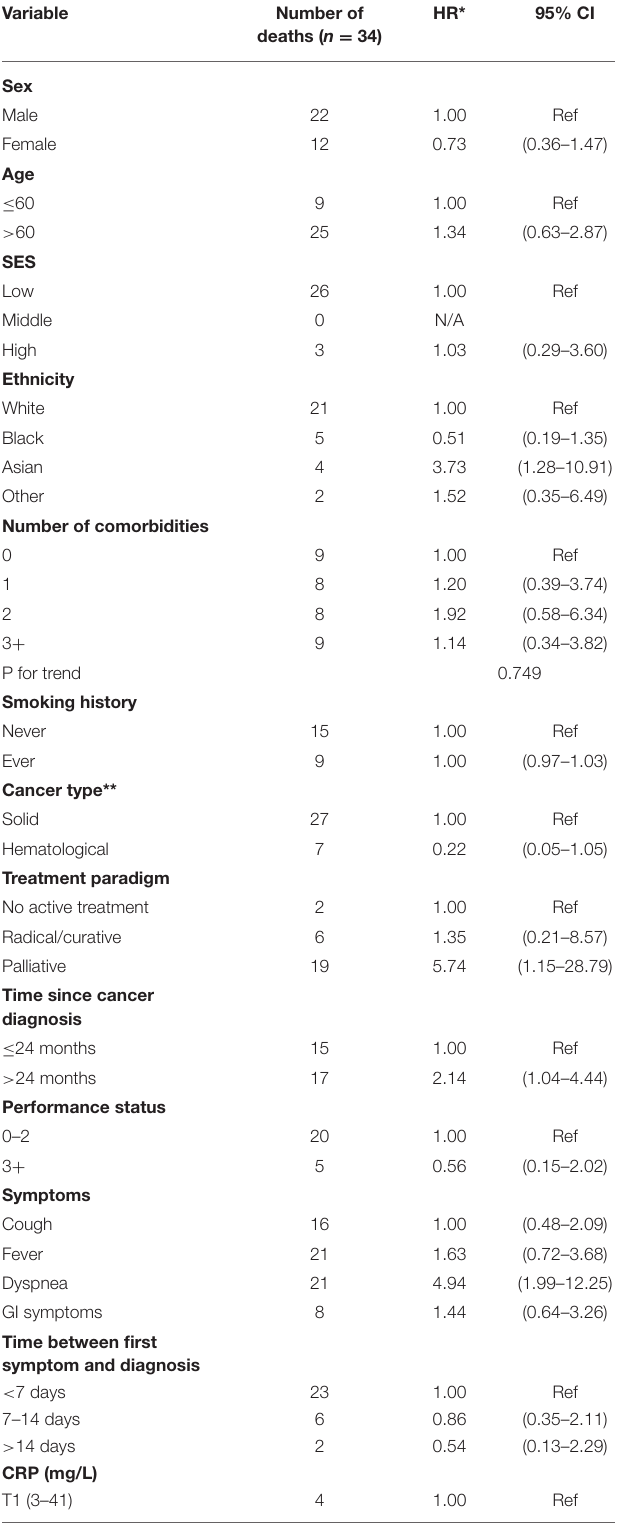
TABLE 5 | Hazard Ratios and 95 %Confidence intervals for COVID-19 death in cancer patients.